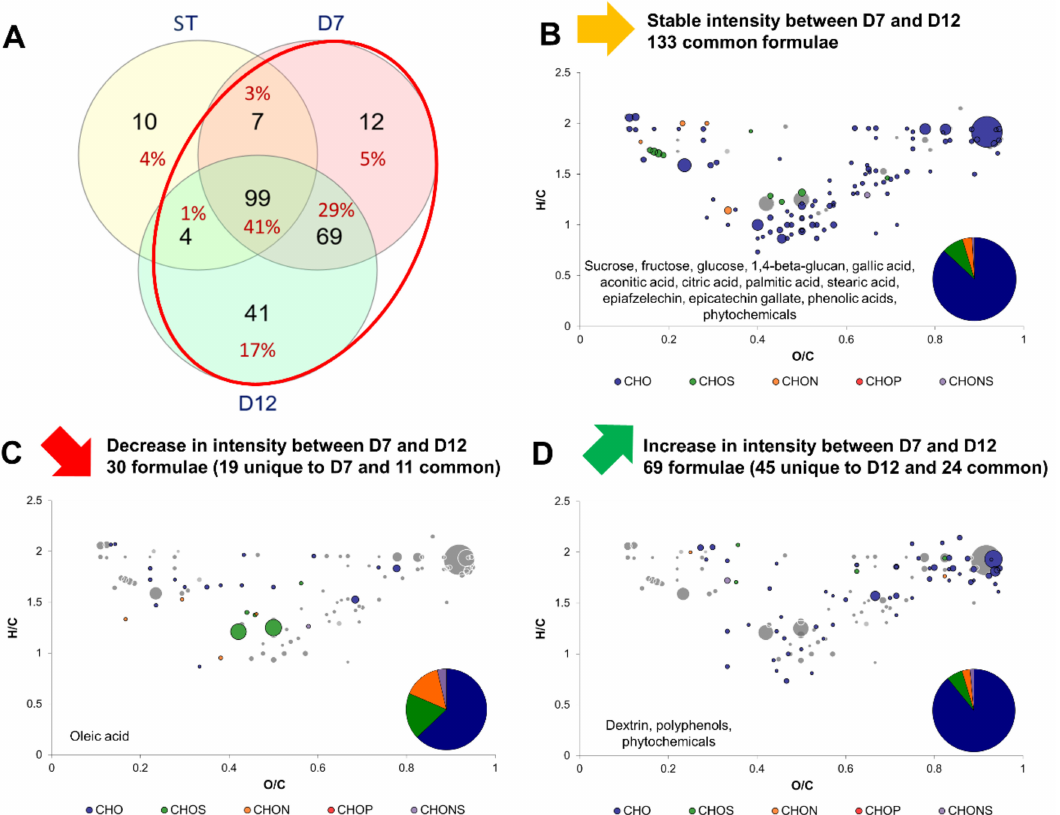
Figure 4. Change in composition between day 7 (D7) and day 12 (D12) kombuchas (common formula between black and green tea kombuchas). ( A ) Venn diagram of formulae identified at each process step: Sugared tea (ST), day 7 (D7) and day 12 (D12) with focus on the comparison of D7 with D12 (red circle). Van Krevelen diagrams and putative identities of ( B ) stable, ( C ) decreasing and ( D ) increasing formula between D7 and D12. The surface of bubbles expresses relative formulae intensity. Core metabolites formulae (Figure 2B) are represented in the background in